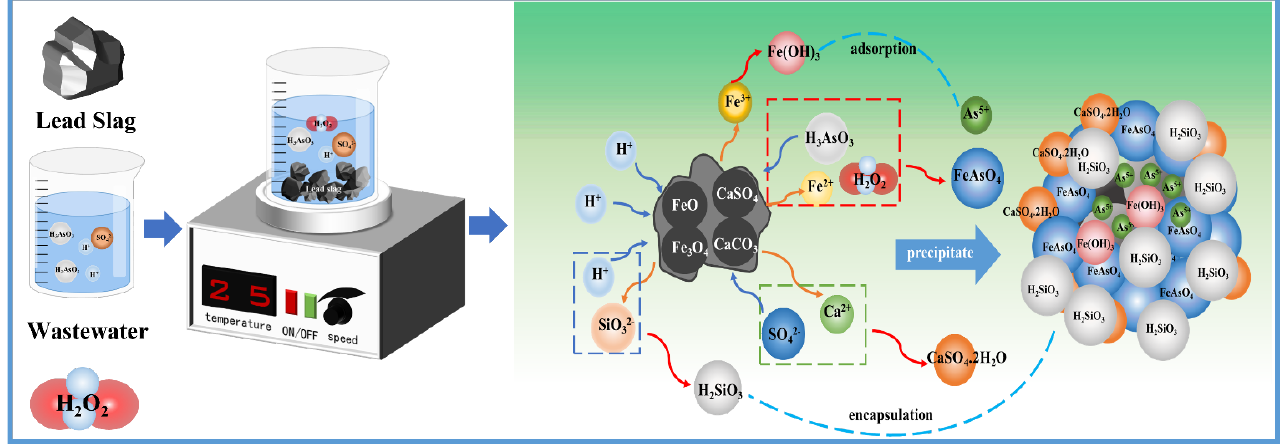
Figure 12. Mechanistic diagram of arsenic removal and immobilization in the treatment of arsenic- bearing wastewater using lead slag.